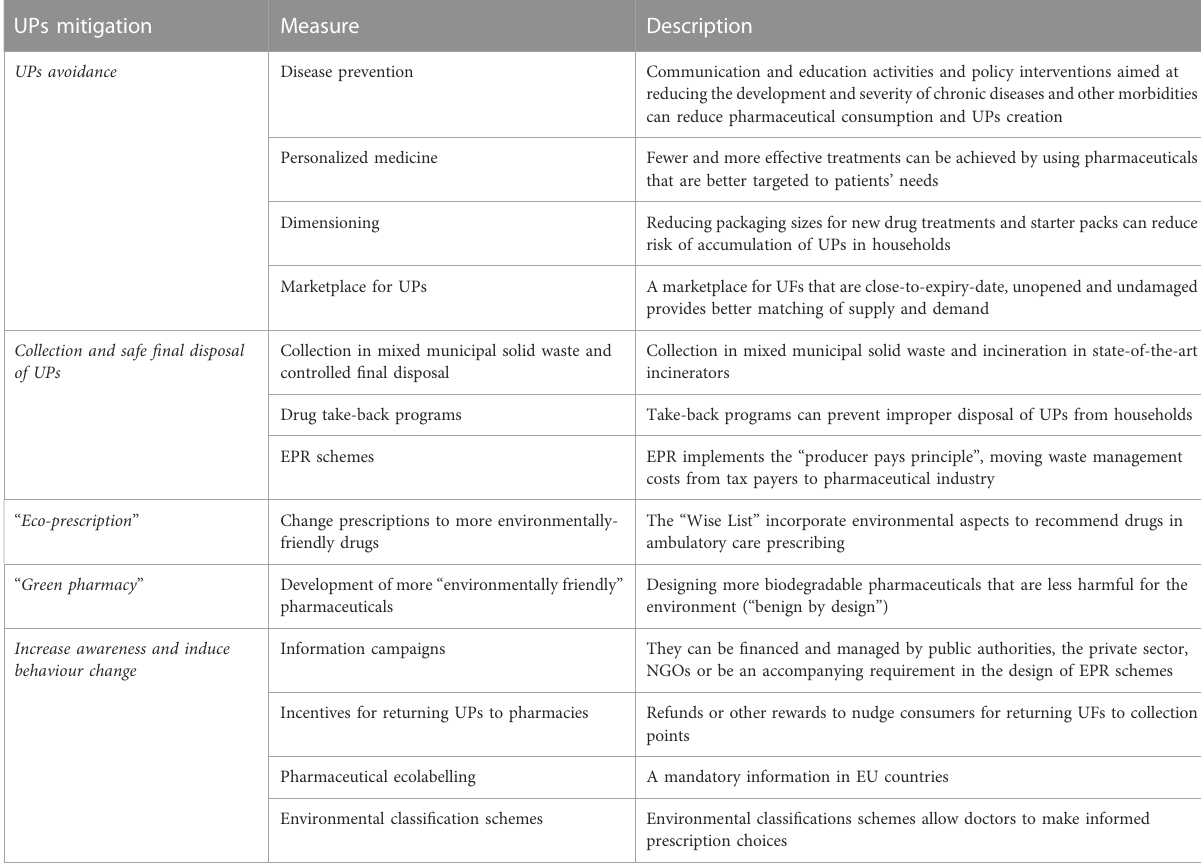
TABLE 1 Measures to mitigate impacts of